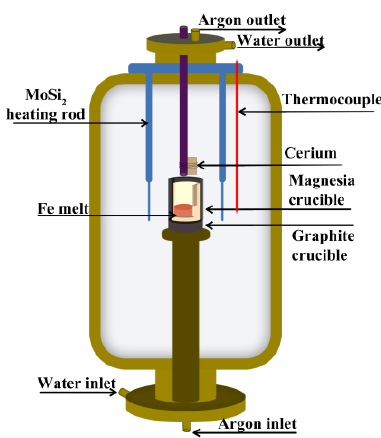
Figure 1. Schematic diagram of silicon molybdenum tube furnace.